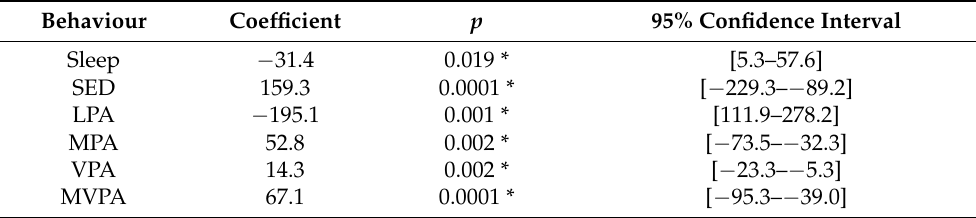
Table 3. Change in time spent asleep and in each activity intensity using the CF-specific relative to generic